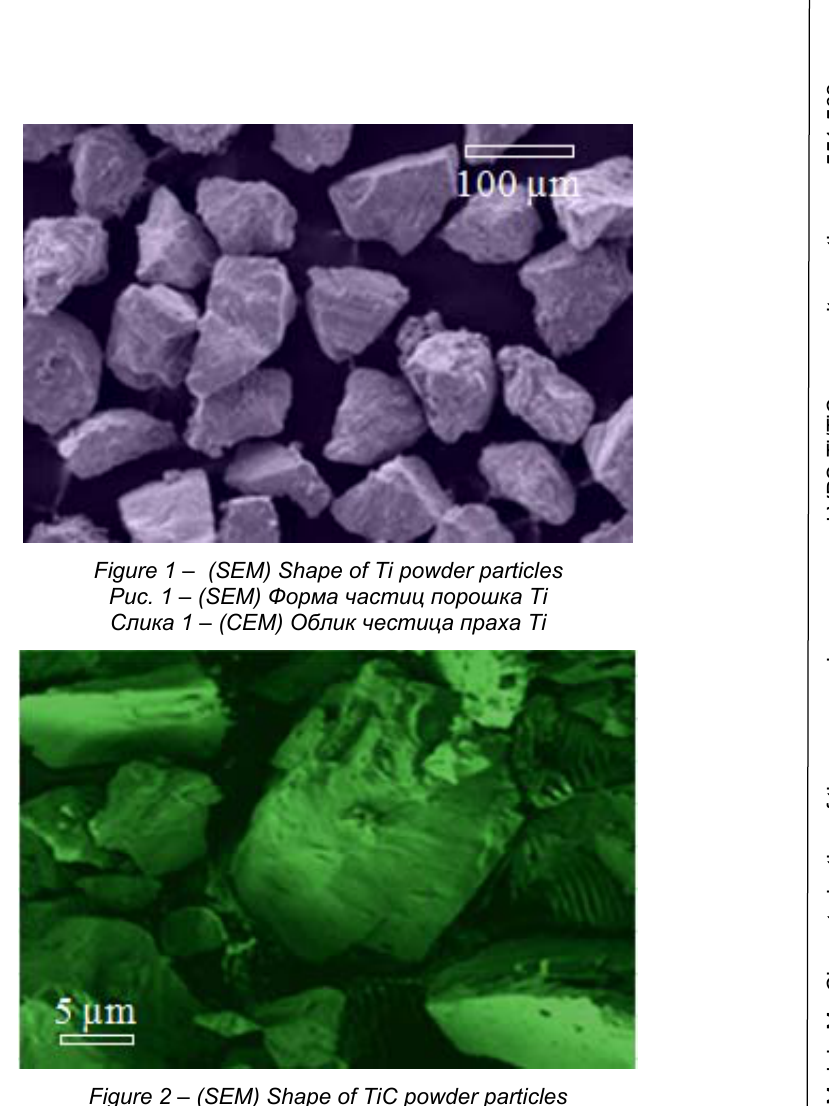
Figure 2 – (SEM) Shape of TiC powder particles Рис . 2 – (SEM) Форма частиц порошка Ti С Слика 2 – ( СЕМ ) Облик честица праха